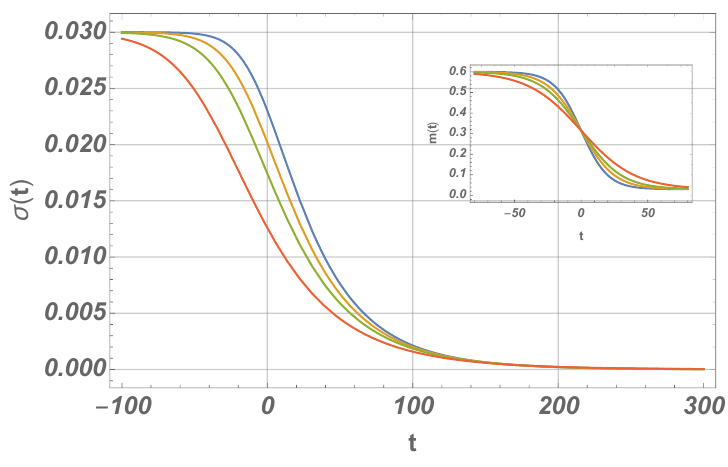
Figure 5 . Plot of (cid:27) ( t ) vs. t for the various rates. The inset curve shows the various quench pro(cid:12)les of m ( t ). The colours correspond to di(cid:11)erent rates, blue: 1/20, orange: 1/25, green: 1/30 and red: 1/40.